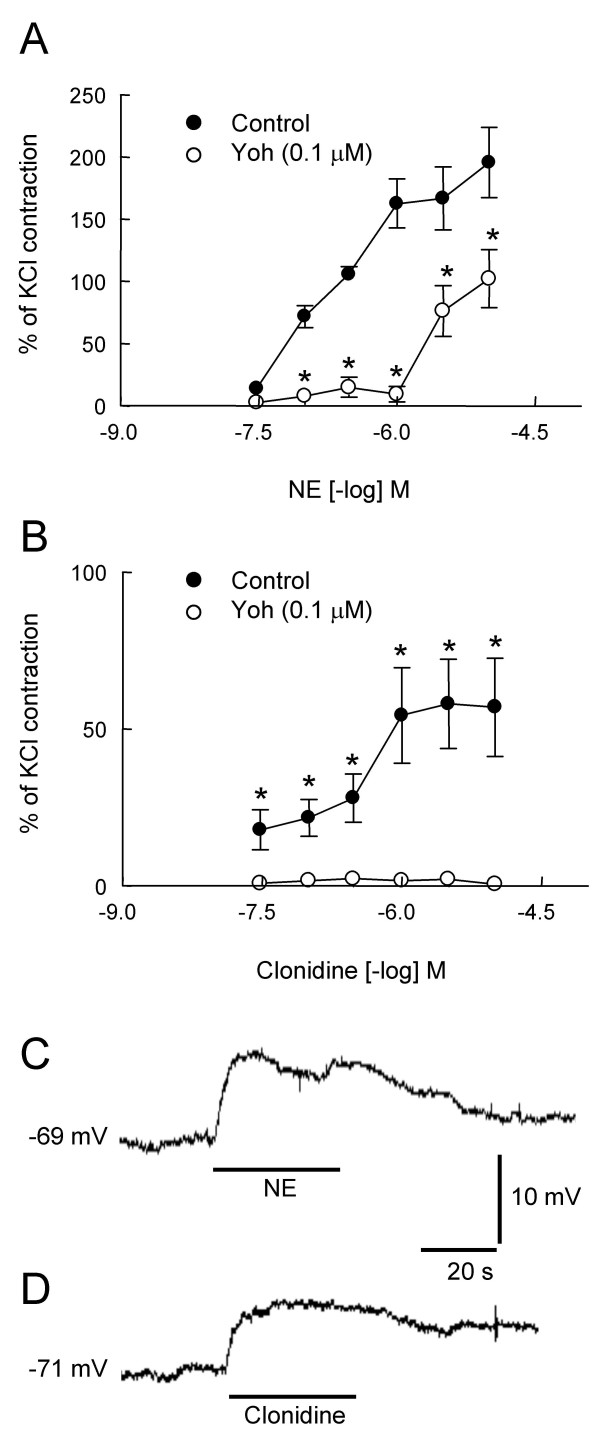
The α2-adrenoceptor blocker yohimbine reduces the contractile responses of canine isolated mesenteric vein to norepinephrine (NE) and clonidine. Contractile responses of control and yohimbine-incubated tissues (0.1 μM, 30 min) to exogenous NE (A) and clonidine (0.05–10 μM each). Contractile responses were expressed as percentage of the contractile response to 70 mM KCl. Data are presented as mean ± SEM, n = 4–8. *, P < 0.05. Representative traces of intracellular recordings of membrane potential changes elicited by NE (0.1 μM, 30 s, panel C) or clonidine (1 μM, 30 s, panel D). Scale bars apply to traces C and D.